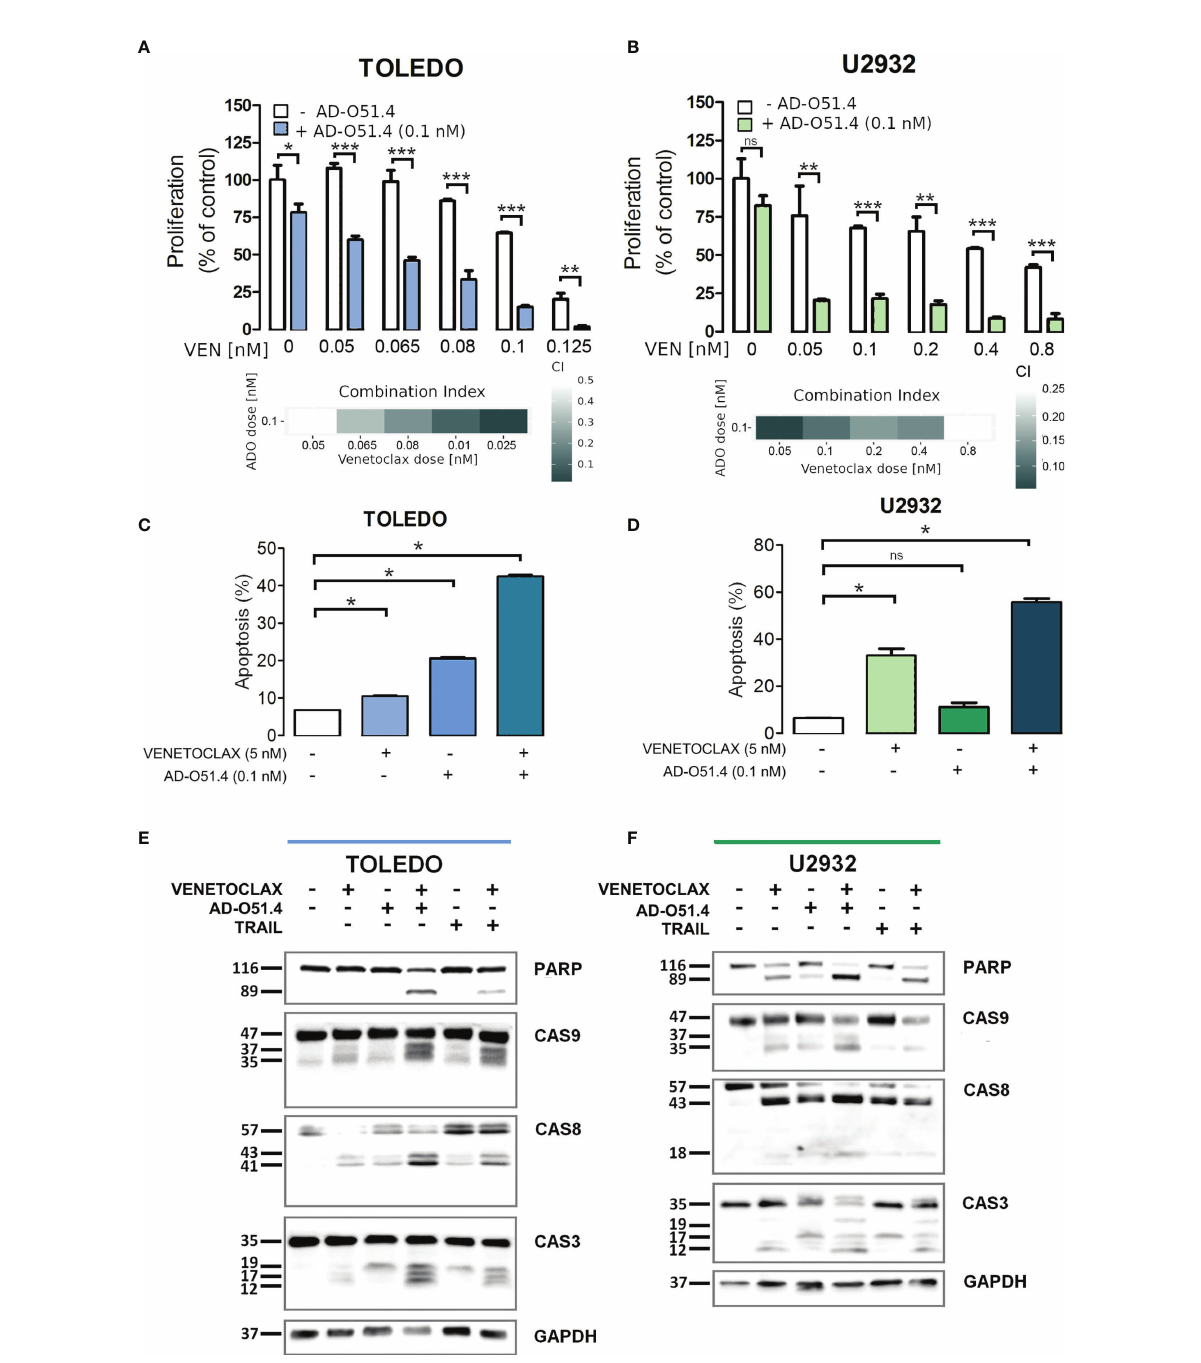
FIGURE 6 Venetoclax sensitizes resistant DLBCL cells to AD-O51.4 A, B . Primary resistant TOLEDO and U2932 cells were preincubated (5h) with indicated doses of venetoclax and then treated with AD-O51.4 for 72 h. Cell viability was assessed using an MTS assay in triplicates. Results were normalized to control (untreated) cells. Combination indexes (CI) for all dose combinations are indicated below the plots. C, D. Increased apoptosis in primary resistant TOLEDO and U2932 cells incubated with a combination of venetoclax and AD-O51.4. Cells were preincubated (5h) with 5 nM venetoclax and subsequently treated with z 0.1 nM AD-O51.4 for 24 h. Apoptosis was assessed using Annexin V/PI staining. Bars indicate the average of the combined fraction of early and late apoptotic cells (PI-/AnnexinV+ and PI+/AnnexinV+, respectively) from three replicates. Error bars indicate standard deviations. E, F. Expression and cleavage of caspase 3, 8, 9 and PARP in TOLEDO and U2932 cells after 1 h of preincubation with venetoclax (5 nM) and subsequent 5 h treatment with 0.1 nM AD-O51.4. In panels A-D, statistical differences were evaluated by t -test; *p-value<0.05, **p-value<0.005, ***p-value<0.001, ns – not signi fi